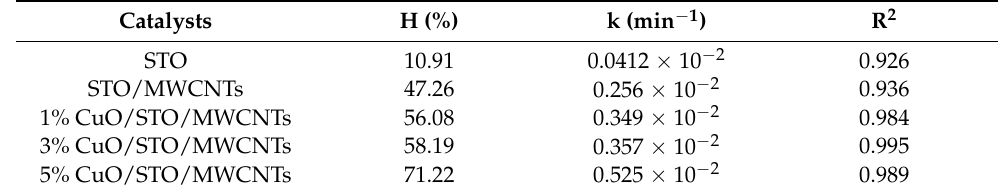
Figure 11. The plots of ln(C o /C t ) in the presence of ( 1 ) STO, ( 2 ) STO/MWCNTs, ( 3 ) 1% CuO/STO/MWCNTs, ( 4 ) 3% CuO/STO/MWCNTs, ( 5 ) 5% CuO/STO/MWCNTs. Table 1. The photodegradation efficiency (H %) and pseudo-first-order rate constant (k). Catalysts H (%) k (min − 1 )